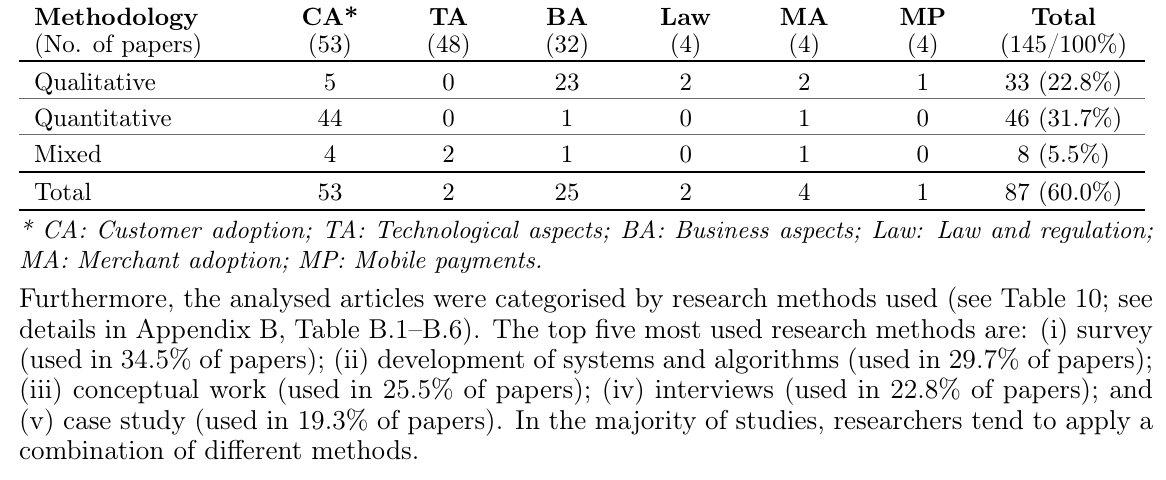
Table 9. Research methodology used in mobile payments research.